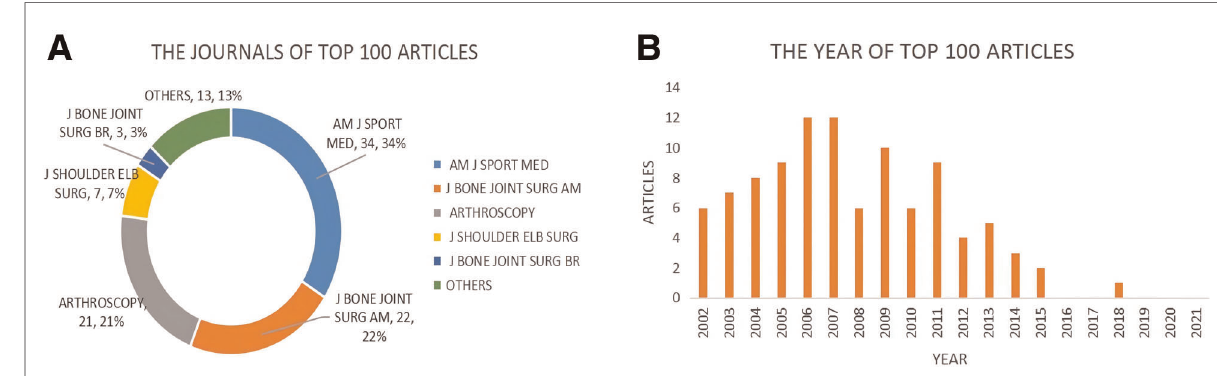
FIGURE 7 The Top 100 most-cited articles of arthroscopic therapy of rotator cuff diseases from 2002 to 2021. ( A ) The journal proportion of the top 100 most- cited articles. ( B ) The annual production of the top 100 most-cited